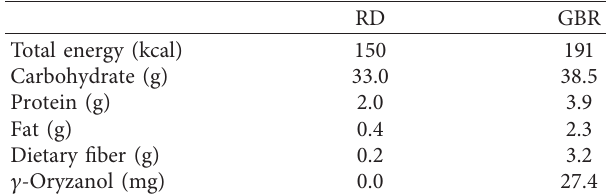
Table 1: Ingredient of the study food. RD difference in the change in BMI between the two groups ( p � 0 . 210; Figure 2(b)). Fasting concentration of plasma glucose ( p � 0 . 356; Figure 2(c)), IRI ( p � 0 . 736; Figure 2(d)), and s-CPR ( p � 0 . 822; Figure 2(e)) were un- changed in both groups.